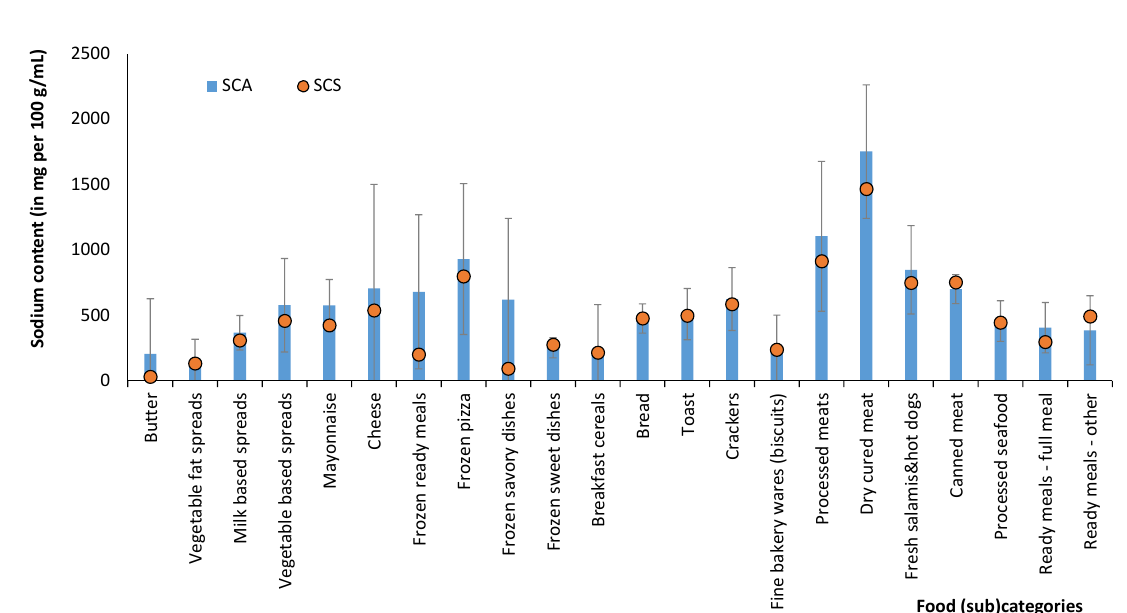
Figure 1. Comparison of average sodium content in available (SCA) and sold (SCS) prepacked foods for selected food